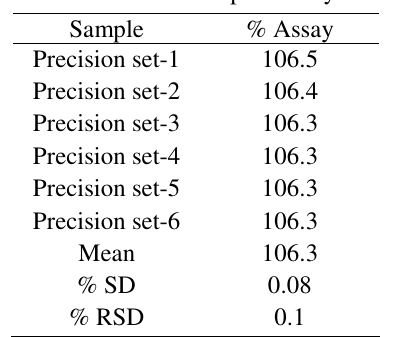
Table 4. Data of method repeatability for